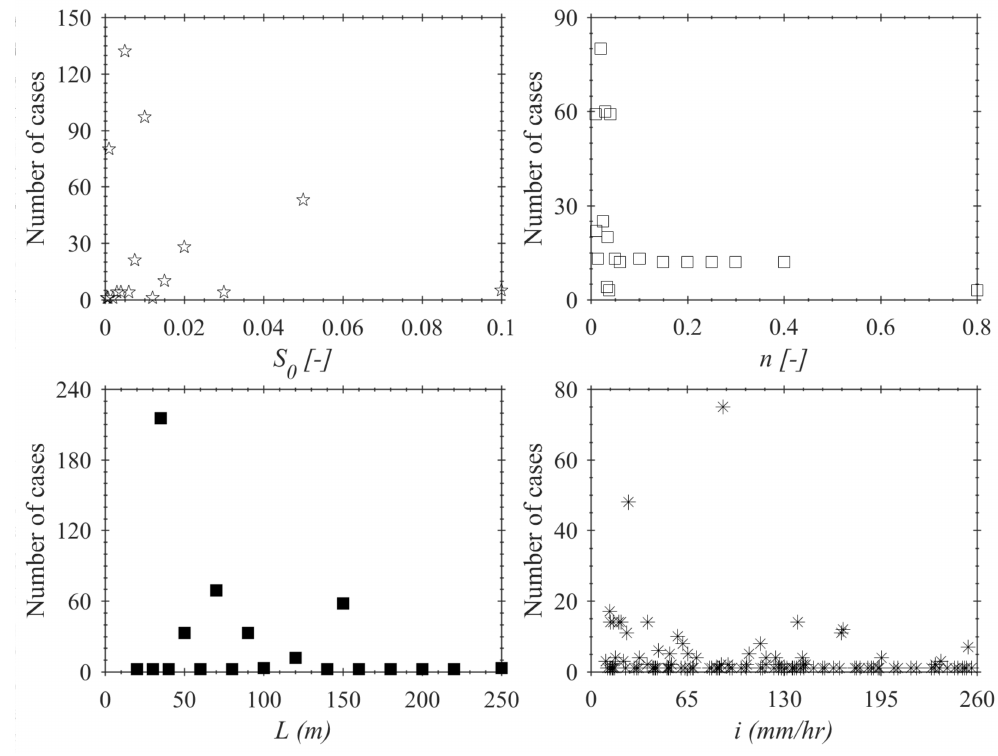
Figure 1. Distributions of the values of four model input parameters used for the 446 impervious modeling